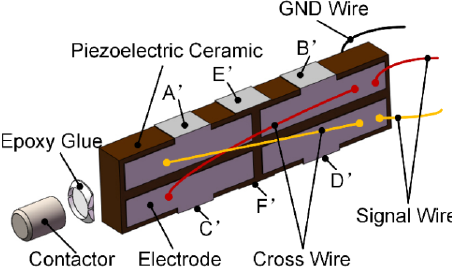
Figure 1. Structure of the piezo ‐ vibrator in the MLPA (multilayer linear piezoelectric actuator), A’,